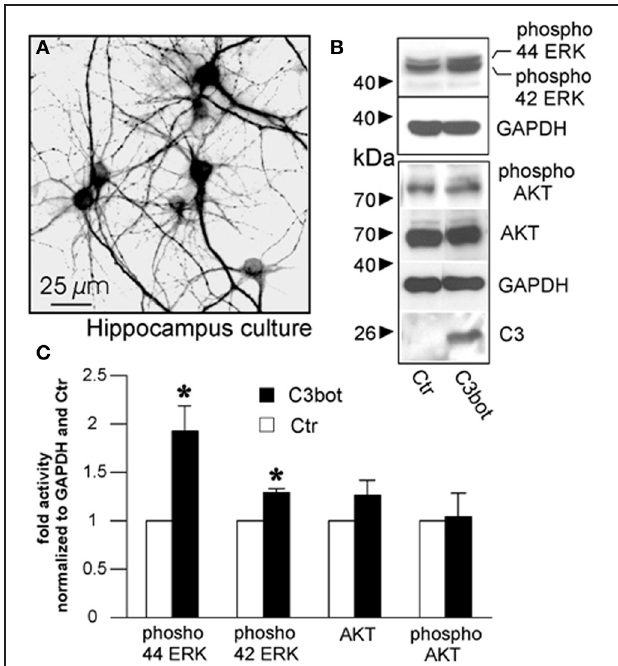
FIGURE 7 | Cultured murine hippocampal neurons treated with C3 bot for 48h stained for microtubule associated protein 2 (A) and subjected to Western blotting (B) . Effects of C3 bot treatment on ERK and Akt phosphorylation were evaluated. C3 antiserum is used to confirm presence of C3 bot . Quantification of protein expression reveals a significant promotive effect of C3 bot on both ERK42 and ERK 44 phosphorylation ( C ; total number of neurons per group > 50, three independent experiments, mean ± SEM; ∗ p < 0 .